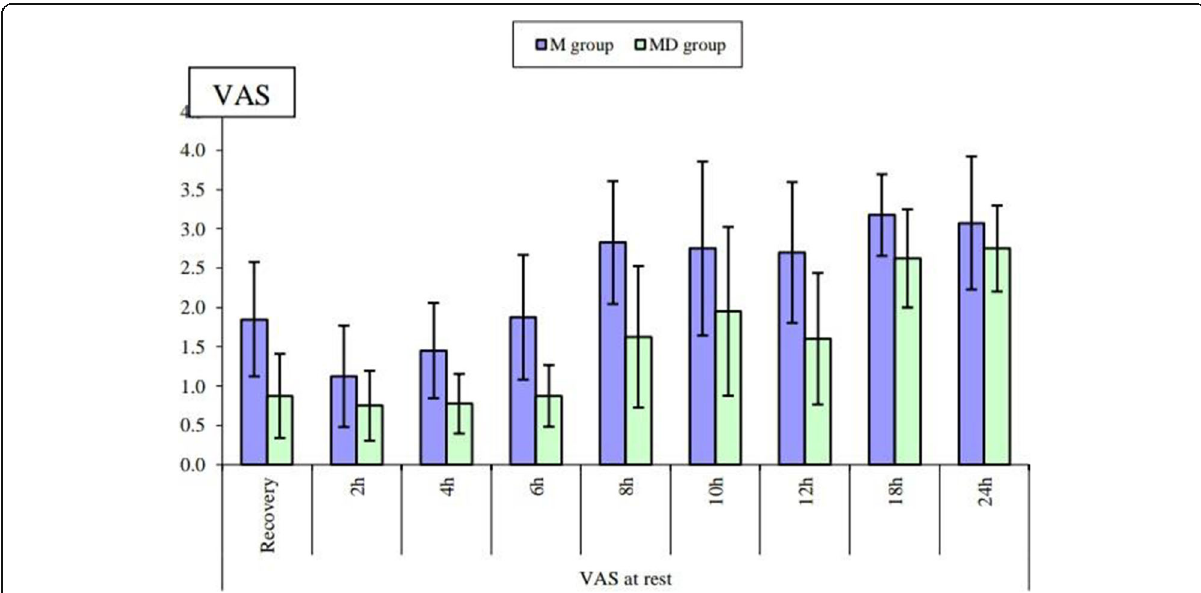
Fig. 1 The mean and SD of VAS at rest within 24 h in the M group and MD group. Numerical variables are presented as means and standard deviations (independent t test)